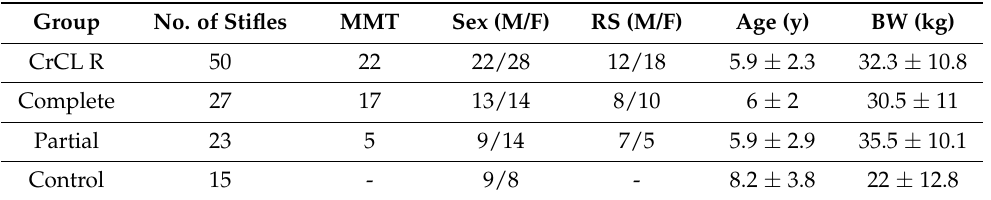
Table 3. Study population characteristics. MMT, medial meniscal tear; RS, reproductive status (the number indicates castrated/spayed dogs); BW, body weight; M, male; F, female. Group No. of Stifles MMT Sex (M/F) RS (M/F) Age (y) BW (kg) CrCL R 50 22 22/28 12/18 5.9 ± 2.3 32.3 ± 10.8 Complete 27 17 13/14 8/10 6 ± 2 30.5 ± 11 Partial 23 5 9/14